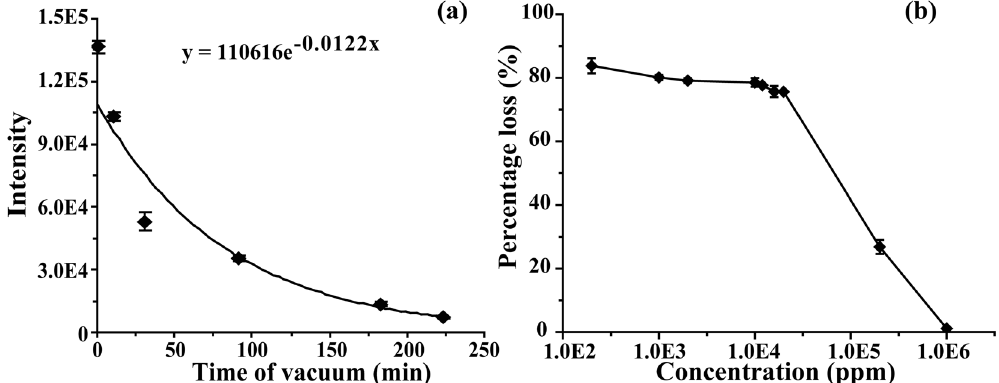
Figure 4. Evaporative loss of 1-pyrroline from aqueous solution with a concentration of 200 ppb as a function of vacuum evacuation time ( a ), and the evaporative loss of 1-pyrroline from DMSO solution at a fixed evacuation time (30 min) as a function of concentration ( b ) measured by APCI-MS analysis.